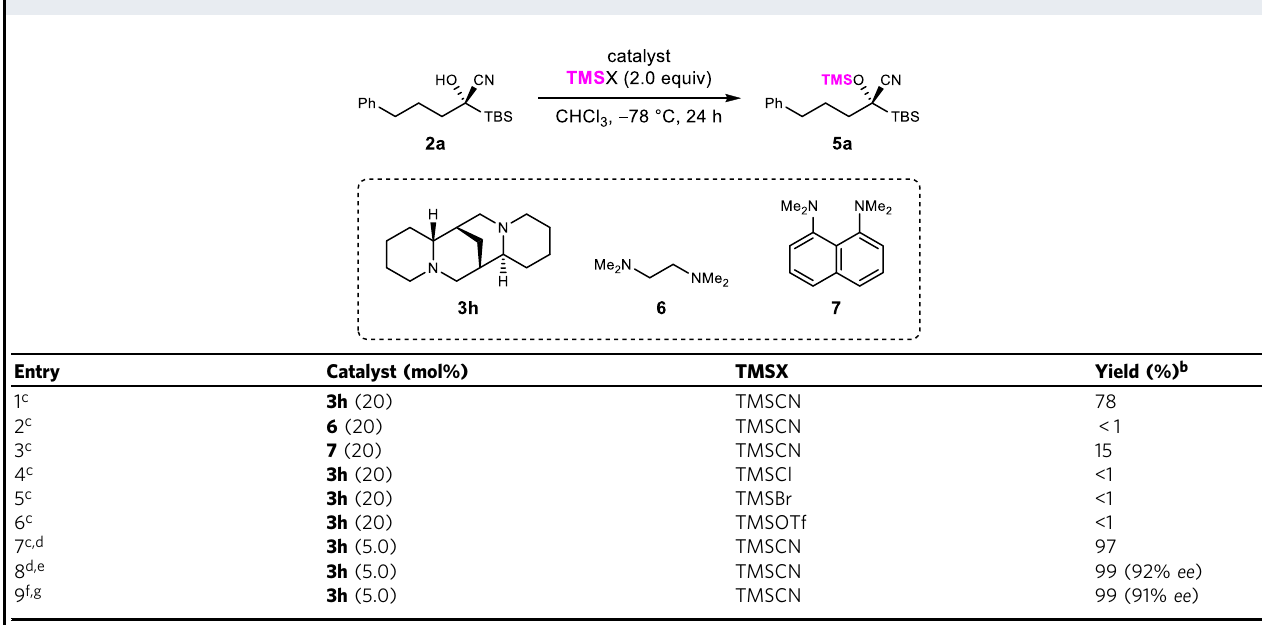
Table 3 Catalytic silylation of 2a a